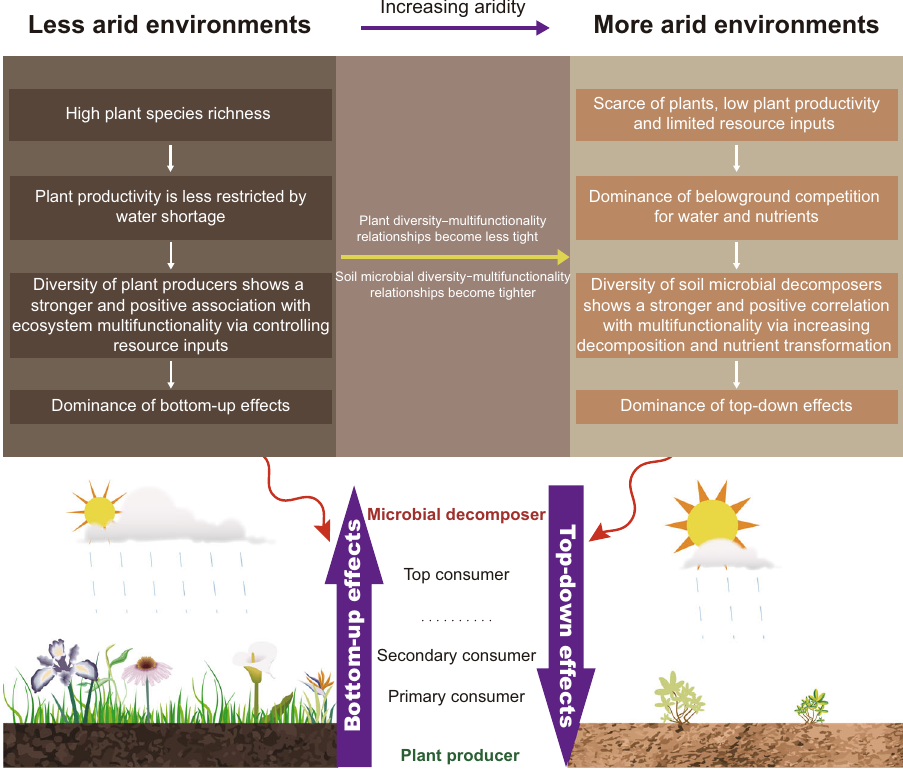
Fig. 1 Aridity mediates the biodiversity – multifunctionality relationships. Schematic diagram illustrating the hypothetical shift in relationships between plant or soil microbial diversity and ecosystem multifunctionality with increasing